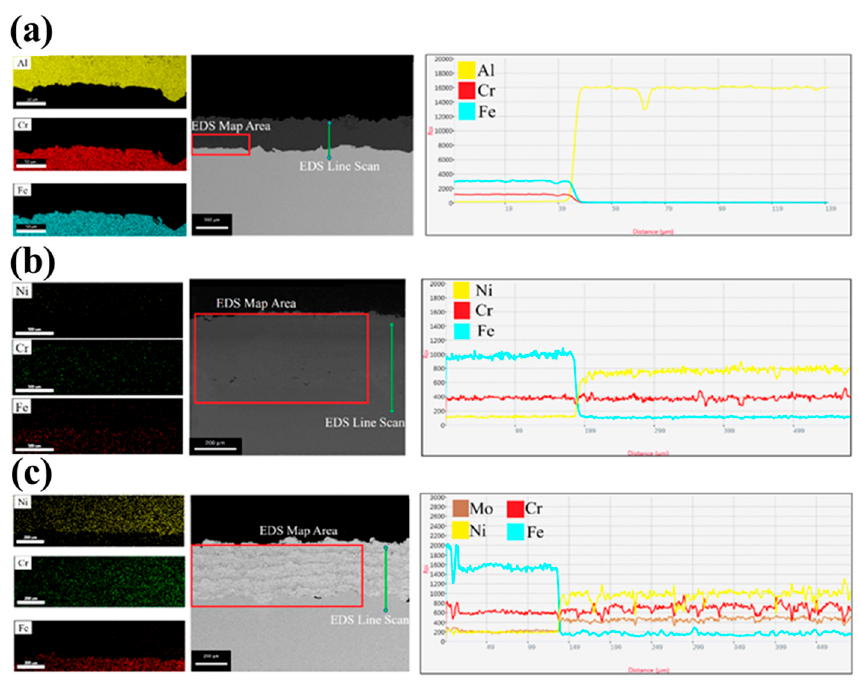
Figure 4. EDS line scan analyses of ( a ) Al, ( b ) Colmonoy, and ( c ) Inconel-coated samples.